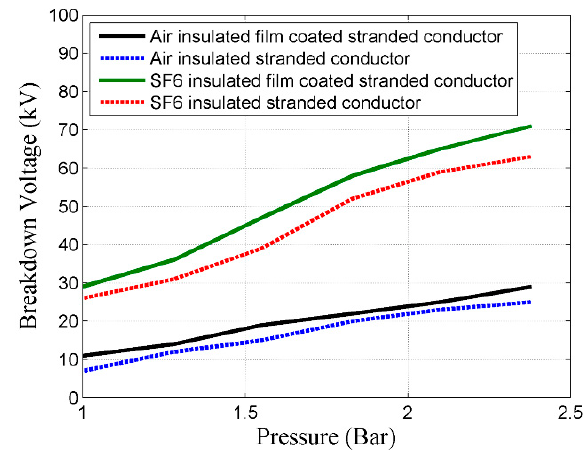
Figure 20. Power frequency disruptive discharge investigations regarding air and SF 6 for different FGIL